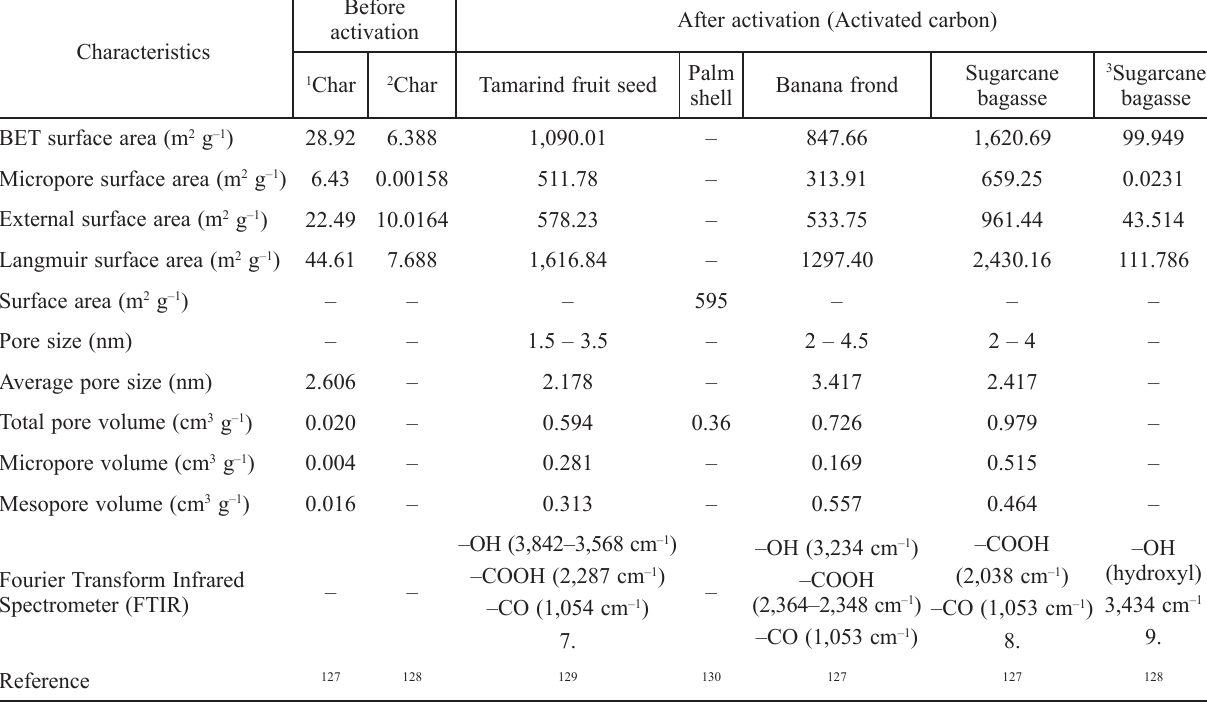
Table 8 – Characteristics of the non-conventional activated carbons